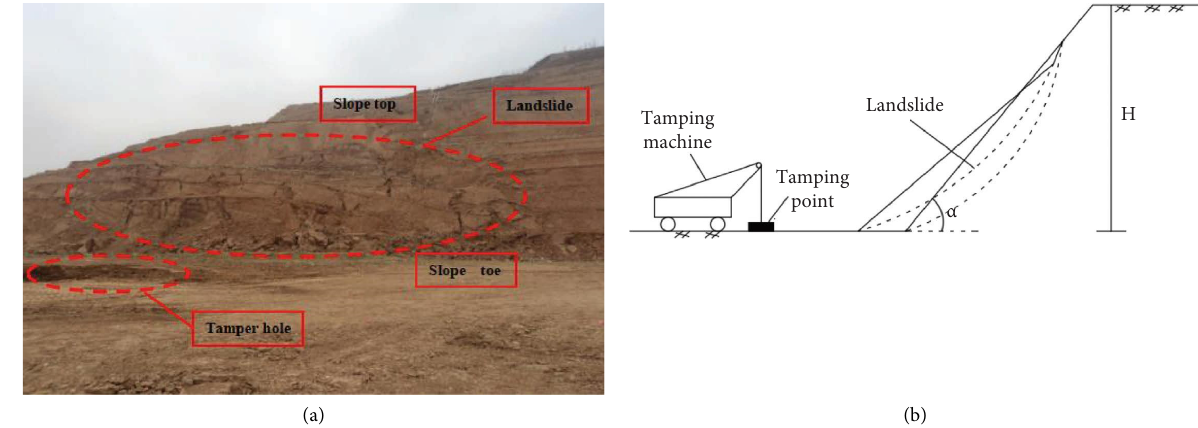
Figure 1: Destruction site of high slope under dynamic compaction. (a) Actual site drawing. (b) Site location diagram.